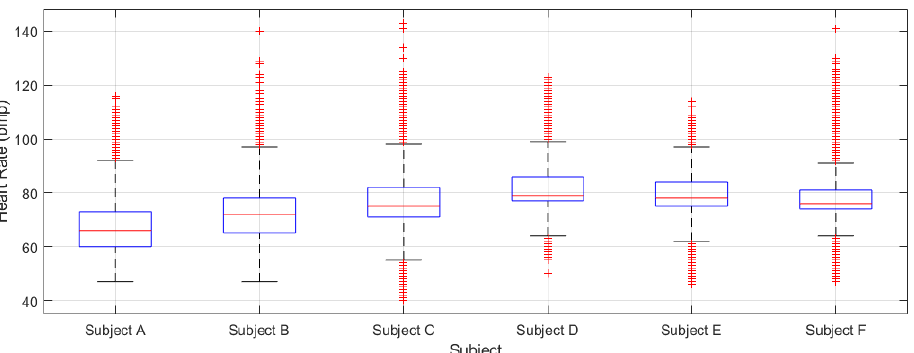
Figure 30. Boxplots of the heart rate registered by the wristbands corresponding to the six participants during the preliminary piloting